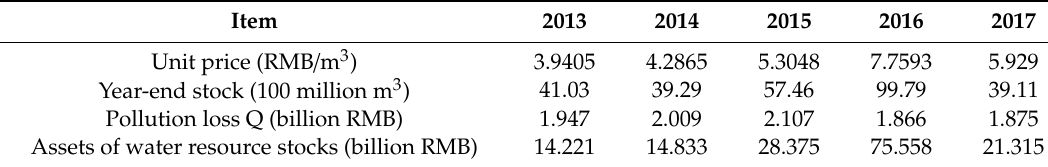
Table 6. Annual water resources value in Wuhan City from 2013 to